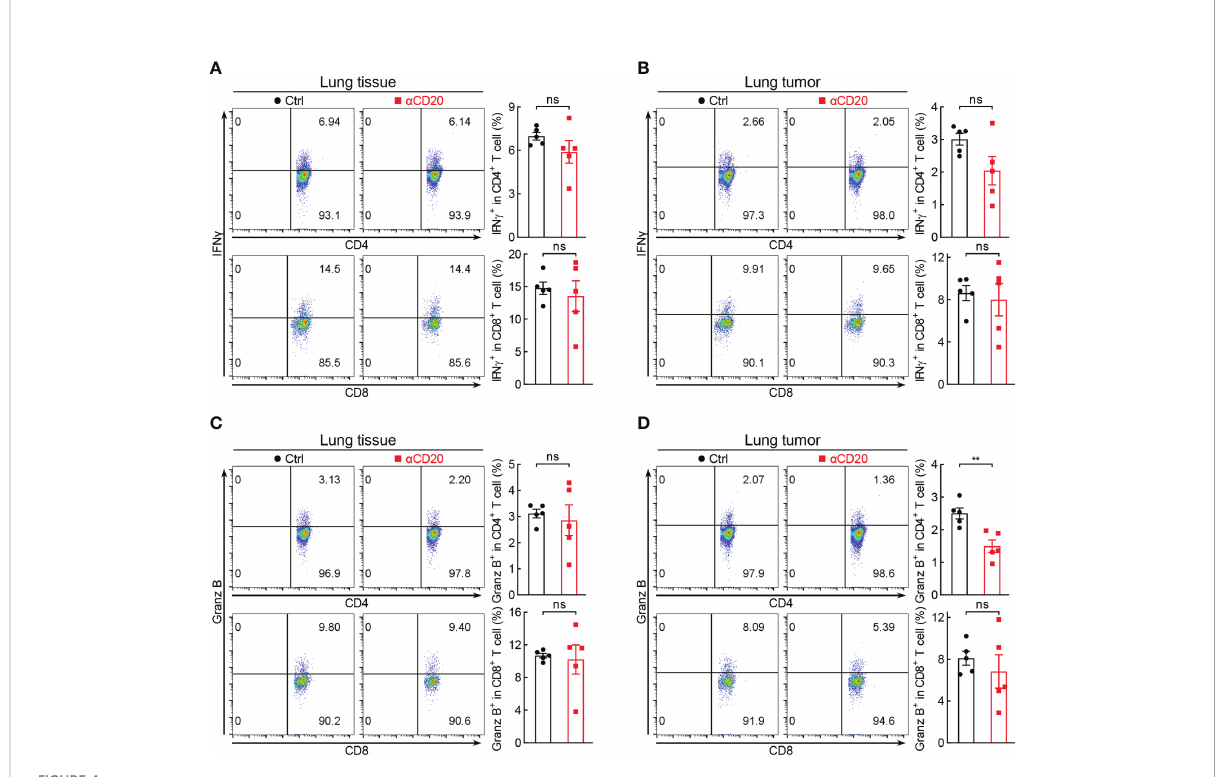
FIGURE 4 B cell de fi ciency has negligible effect on T cell activity in lung cancer. (A, B) FACS data showing comparable expression levels of IFN g in both lung tissues and lung tumors between Ctrl and a CD20 groups (n = 5). (C, D) FACS data showing comparable expression levels of Granz B (granzyme B) in both lung tissues and lung tumors between Ctrl and a CD20 groups (n = 5). Data shown were representative of two independent experiments with similar results. Student ’ s t test (two tailed, unpaired) was performed. Data represented means ± SEM. ** p < 0.01; ns, not statistically signi fi